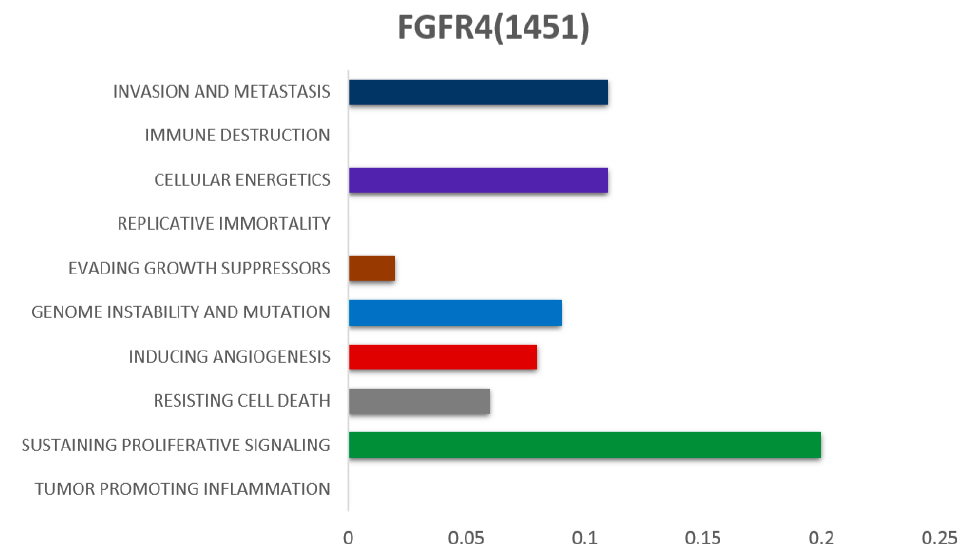
Figure 2. The association of FGFR4 with different hallmarks of cancer, as reported in the literature. (Scales of bars from left to right represent the lowest to highest number of associations reported)